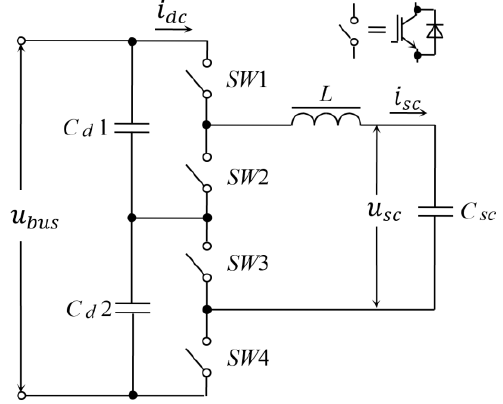
Figure 14. Three-level topology of DC/DC converter.